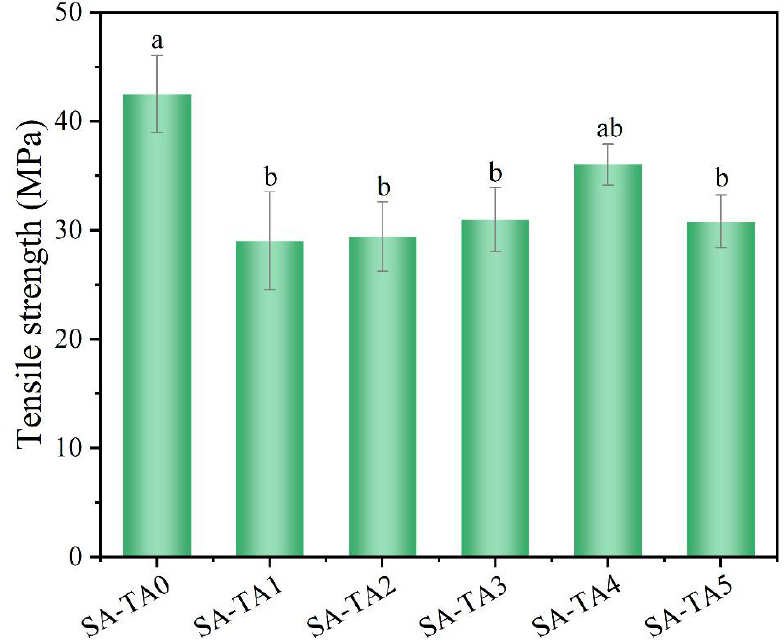
Figure 6. Tensile strength of SA and SA-TA films. Different letters indicate significantly different groups ( p < 0.05) based on ANOVA followed by Tukey test.